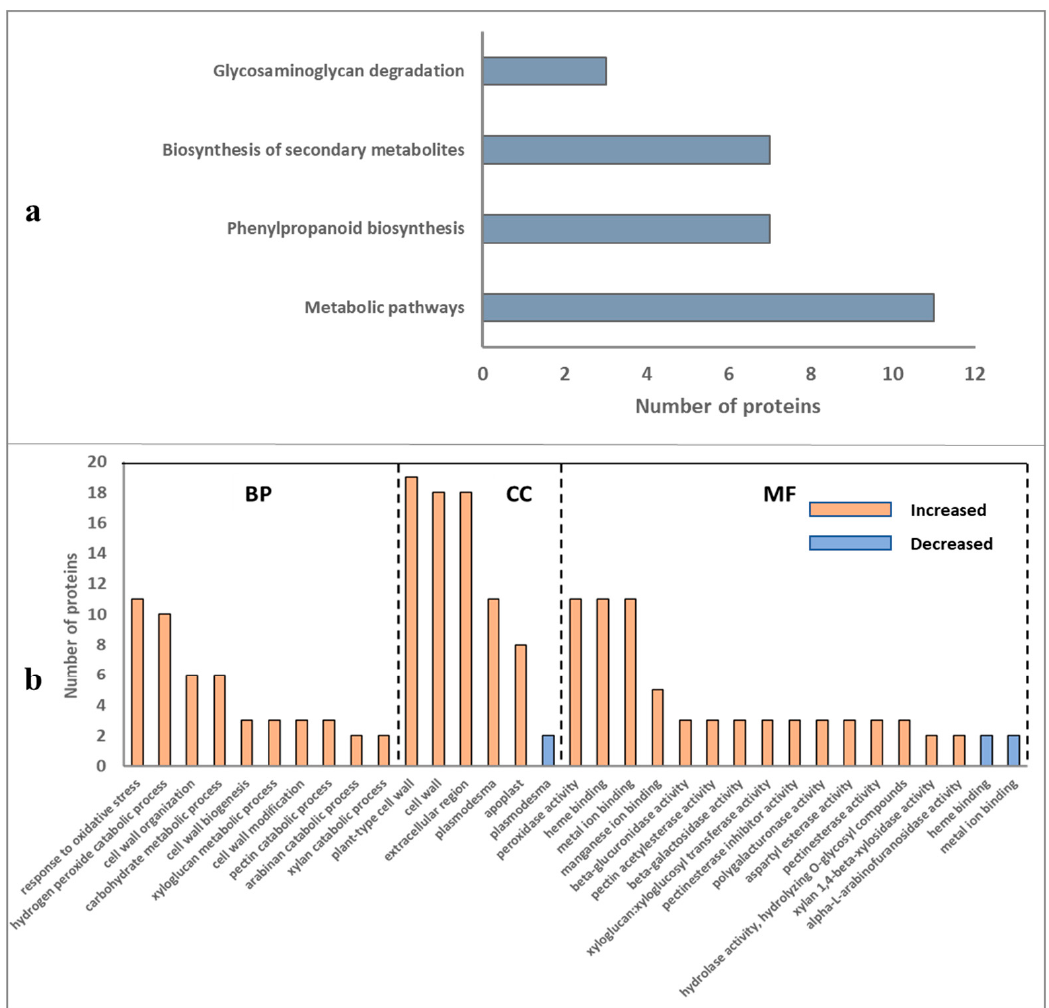
Figure 5. ( a ) Pathway analysis of cell wall related proteins that were increased in resistant potato (Solanum tuberosum) cultivars; ( b ) classification of root cell wall related proteins that were increased (orange bars) or decreased (blue bars) in resistant cultivars by Gene Ontology (GO) categories for biological process (BP), cellular component (CC), and molecular function (MF). Table 1. Differentially abundant proteins in cell wall. The fold change is on a log 2 scale. Positive fold changes indicate increased abundance in resistant cultivars; negative fold changes indicate reduced abundance in resistant cultivars.